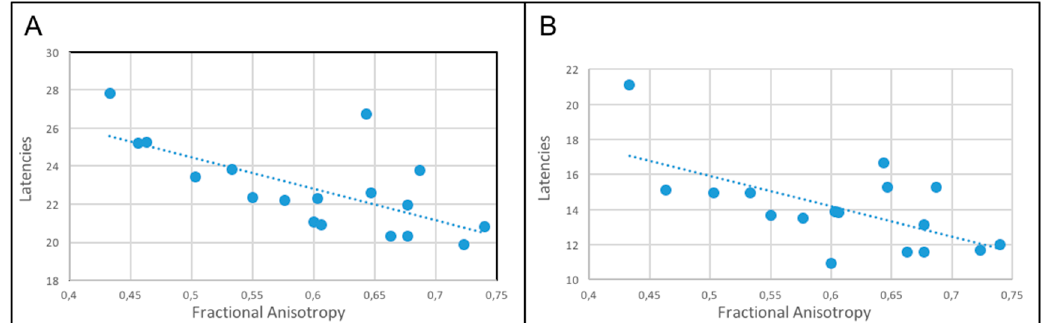
Figure 5. A: Inverse correlation between preoperative FA values and L1 spinous process (N22) ( p = 0.001). B : Inverse correlation between preoperative FA values and popliteal fossa to L1 (N8–N22) ( p = 0.007).